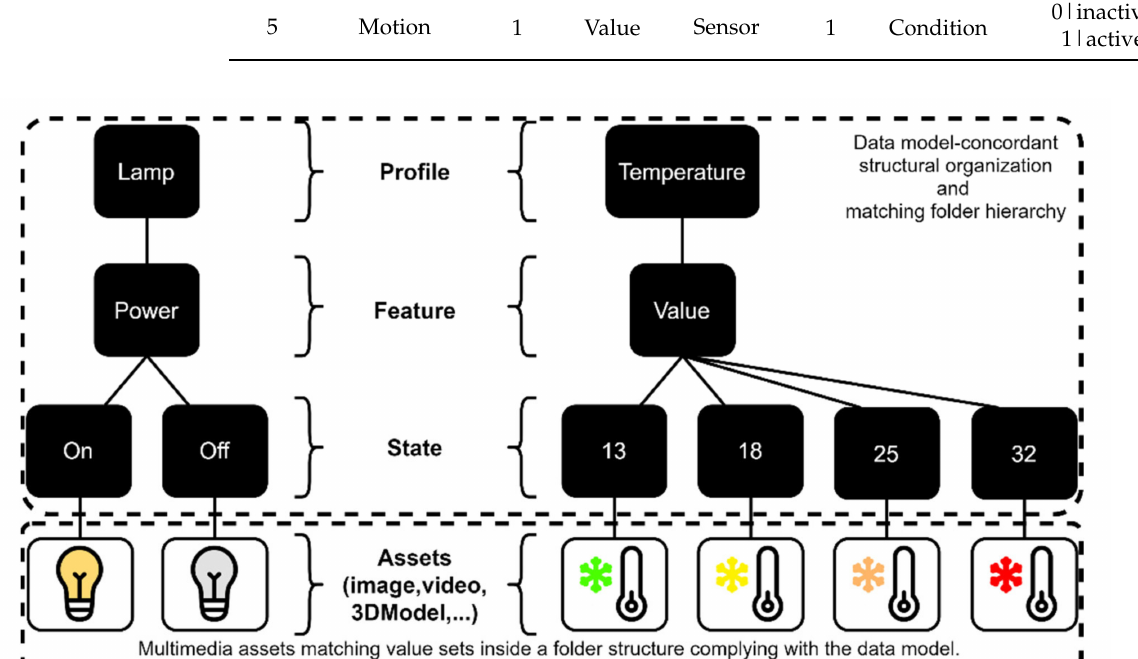
Figure 6. A pair of virtual devices associated to different profiles—an actuator and a sensor—exemplifying things’ state changing process: lamps show a representation of a turned on or off bulb according to a given power state transition, while temperature sensors toggle between different levels of heat, considering a pseudo-random value selected from the respective profile’s predefined set, for instance 13, 18, 25, and 32 (in ◦